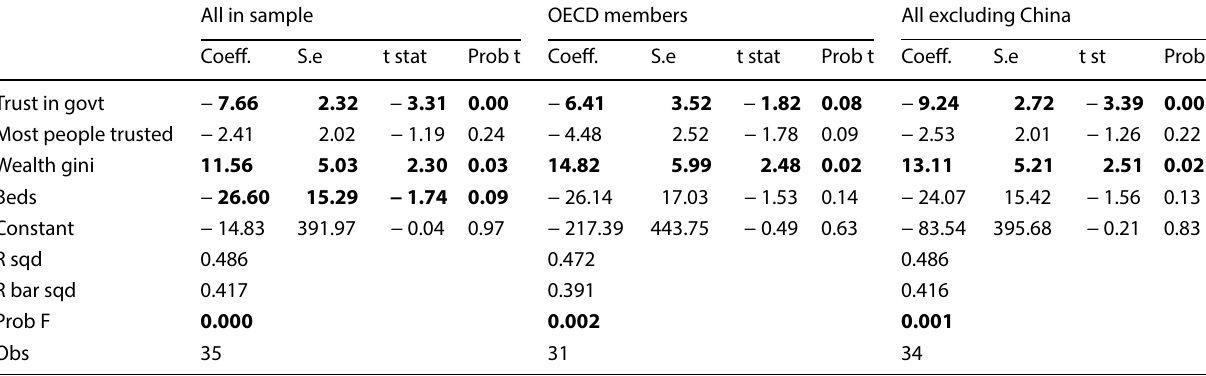
Table 2 Regression results for the first period